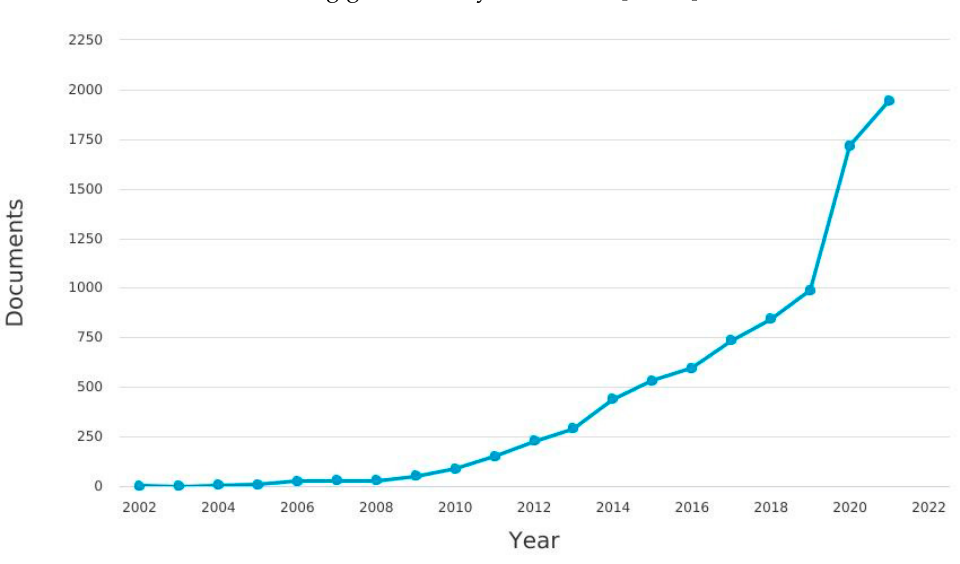
Figure 2. Number of published articles on nanocrystalline cellulose per year from 2002 to 2022 ac- cording to Scopus (keywords: «cellulose nanocrystals», «cellulose nanowhiskers», and «nanocrys- talline cellulose»).